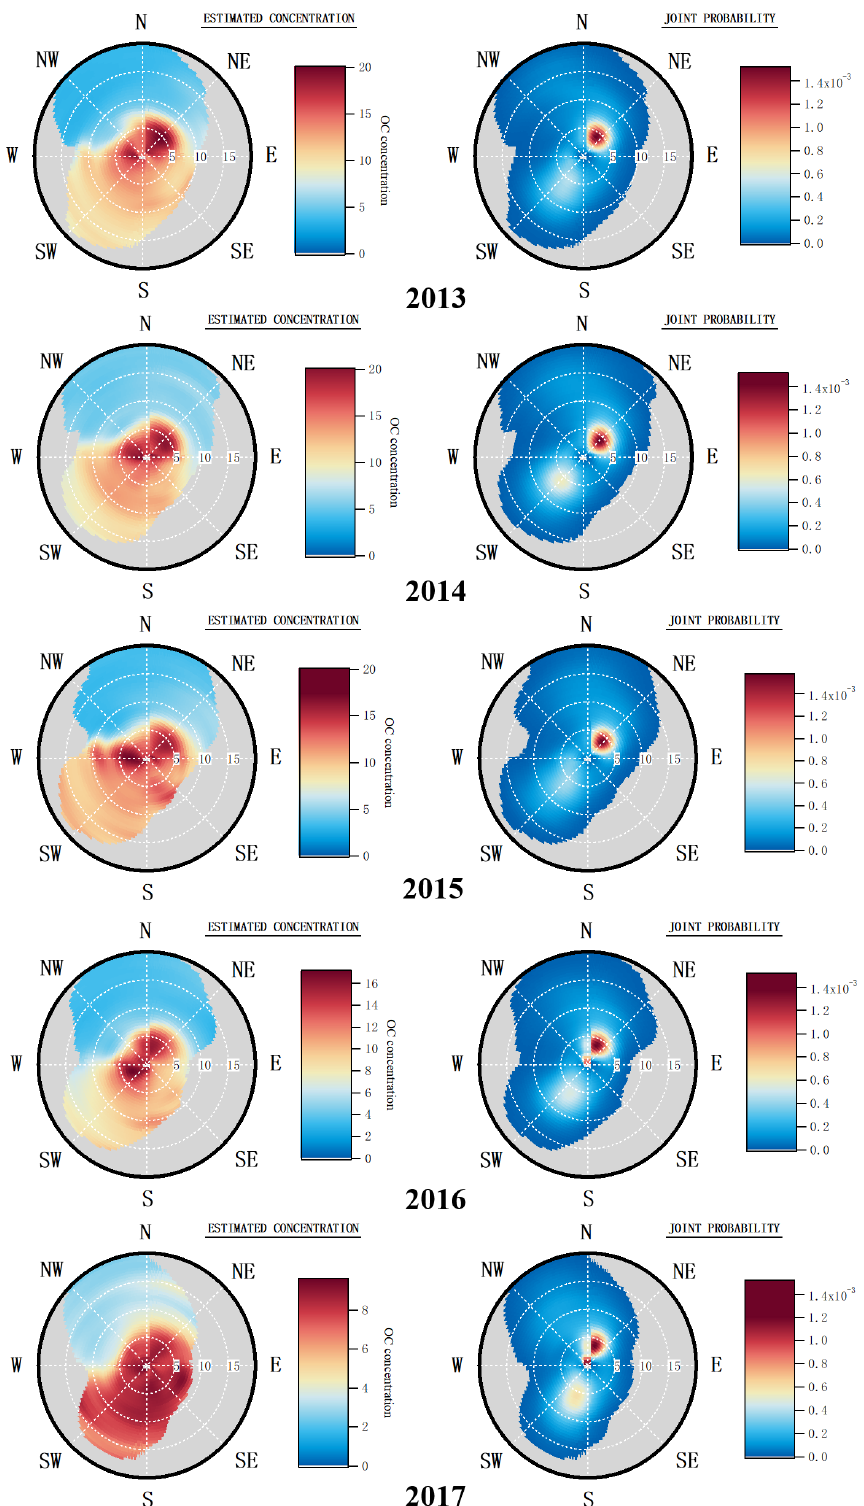
Figure 7. Wind analysis results using NWR on 1h OC concentrations measured in Beijing from 2013 to 2017 (wind speed in kilometres per